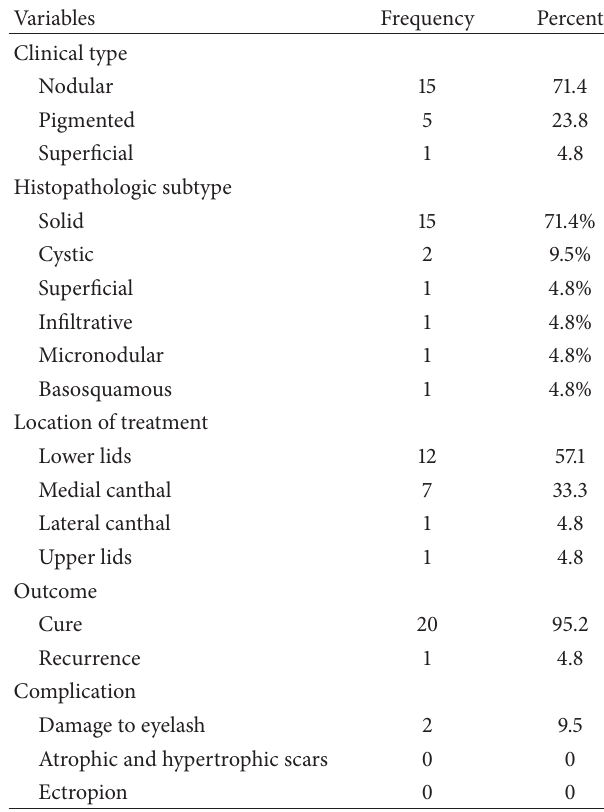
Table 1: Characteristics of patients. Table 2: Characteristics of lesion, outcome, and complication of